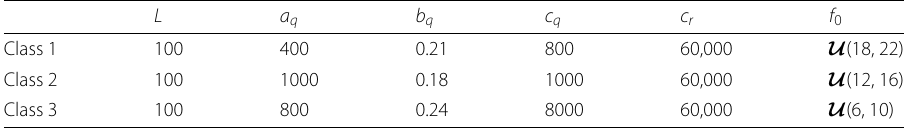
Table 2 Parameters for the three classes of simulated signals.